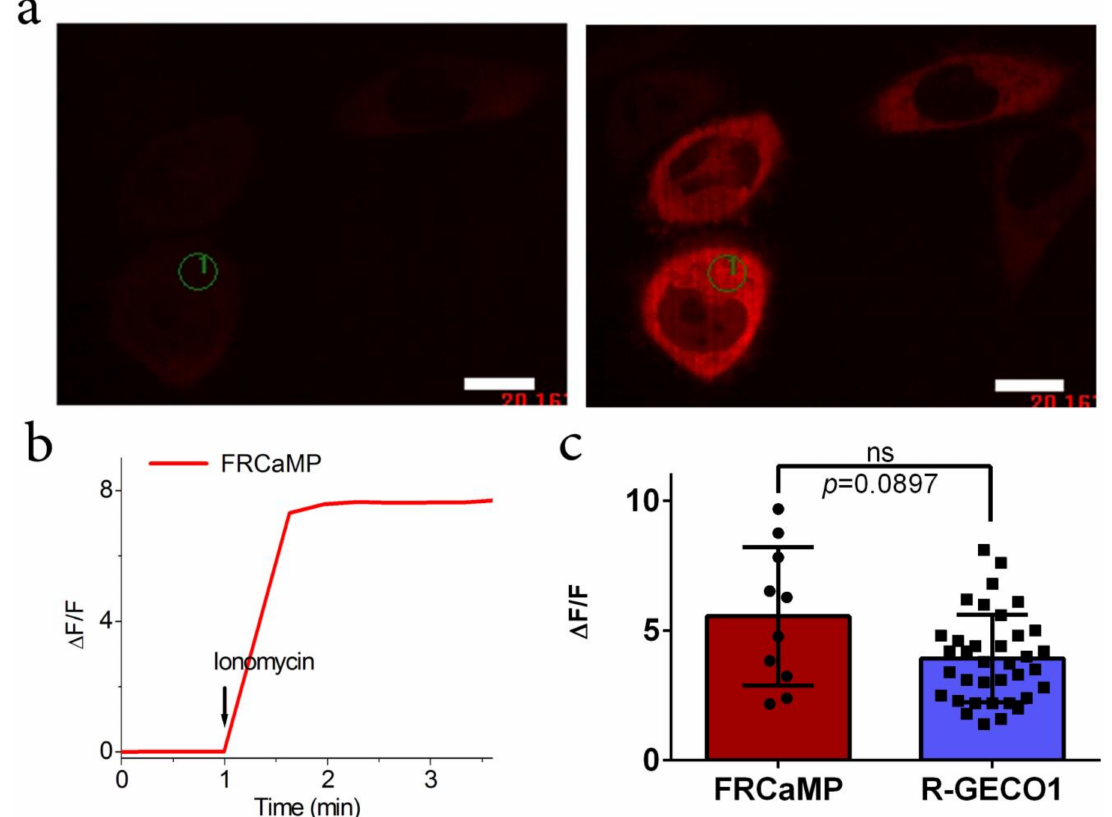
Figure 3. Localization and response of the FRCaMP indicator to Ca 2+ variations in HeLa cells. ( a ) Confocal images of HeLa cells expressing the FRCaMP calcium indicator before and after the addition of 2.5 µ M ionomycin. The red fluorescence channel corresponds to excitation and emissions at 561 and 617/73 nm, respectively. Scale bar, 20 µ m. ( b ) The graph illustrates ∆ F/F changes in the red fluorescence of the FRCaMP indicator in response to the addition of 2.5 µ M ionomycin. The changes on the graph correspond to the area indicated on panel a as a numbered circle. The time of ionomycin addition is shown by an arrow. ( c ) Comparison of the averaged ∆ F/F responses for the FRCaMP (two cultures) and R-GECO1 (seven cultures) indicators in HeLa cells upon 2.5 µ M ionomycin addition in different cell cultures. Error bars indicate the standard deviations across 10–36 cells. p -values show a statistical difference between the respective values. ns, not